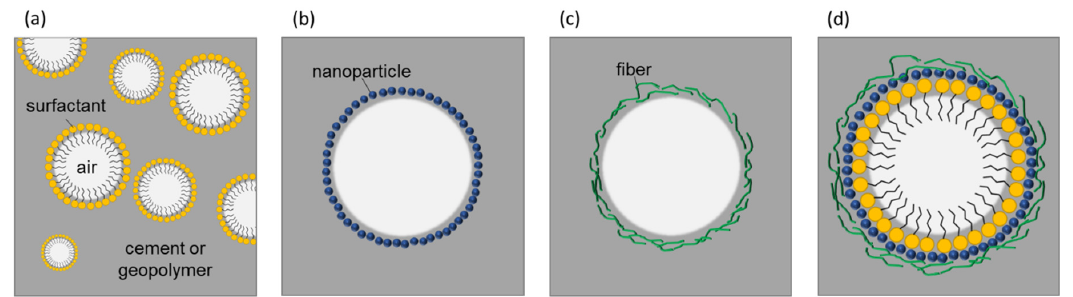
Figure 13. Foam stabilization via ( a ) a surfactant and Pickering emulsion formulated from ( b ) nanoparticles ( c ) fibers and ( d ) surfactant–fiber–nanoparticle (SFN) according to Reference [101].